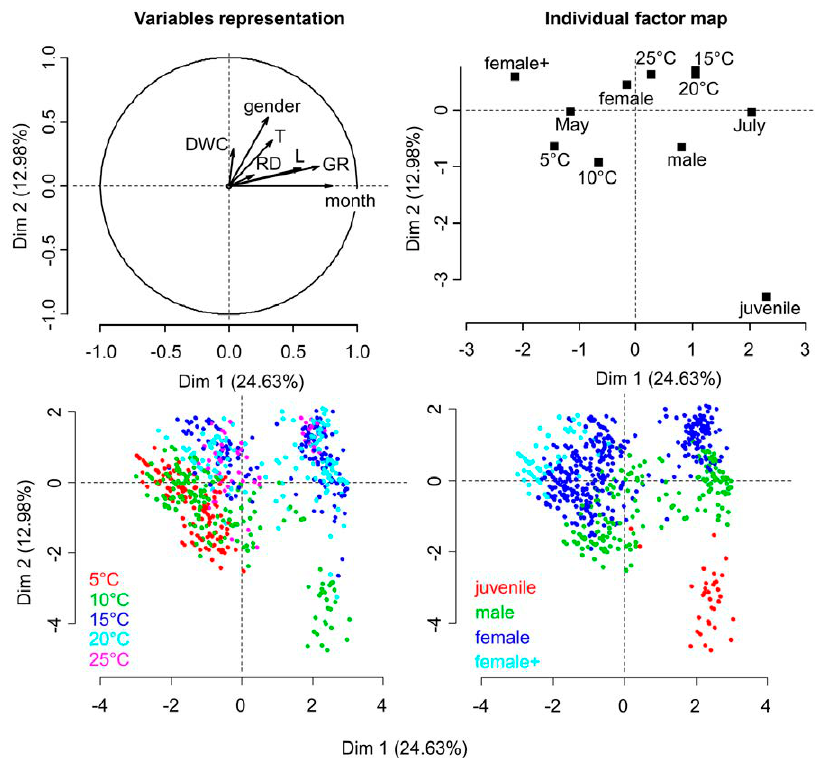
Fig. 2. – Result of the factorial analysis of mixed data. Top left, variables representation; top right, factor map; lower panels, observations by first and second dimension coloured either by the temperatures the shrimps experienced (lower left) or the sex of the shrimp (lower right), where female+ are egg-carrying